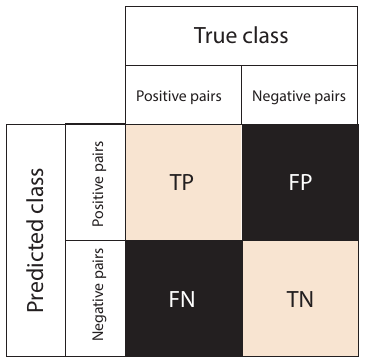
Figure 14. Confusion